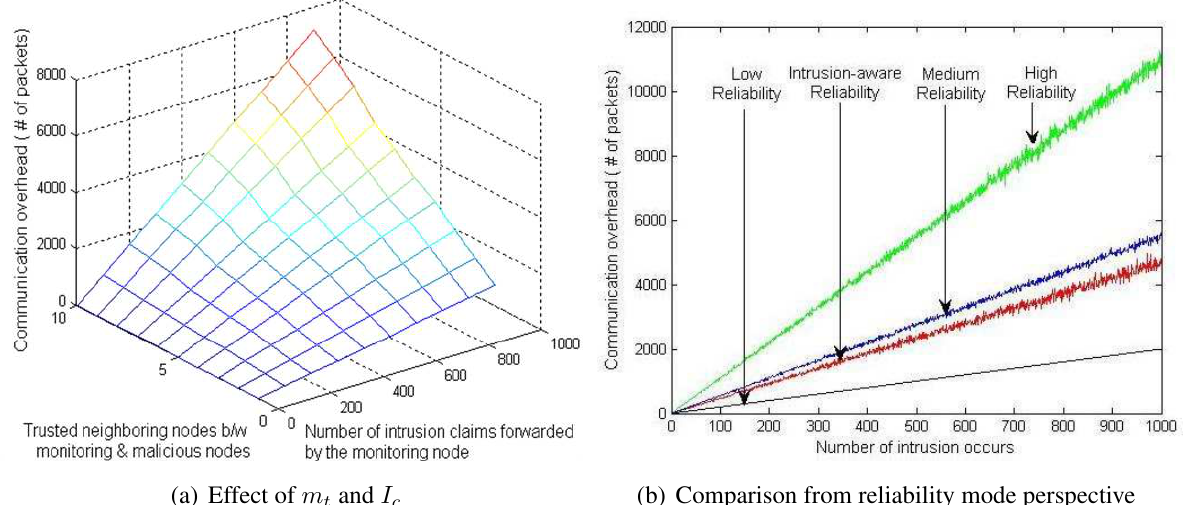
Figure 5. Average communication overhead of validation algorithm after 1000 simulation runs in which different levels of intrusions occurs